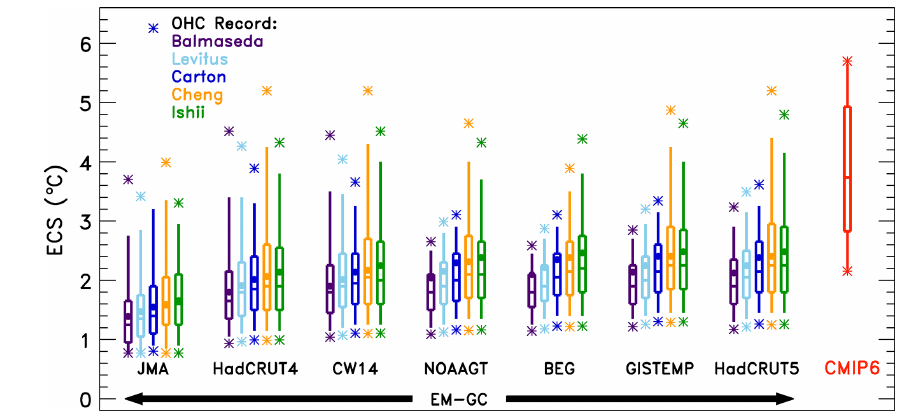
Figure 7. ECS from the EM-GC and the CMIP6 multi-model ensemble. Seven GMST data sets and five ocean heat content records are used to compare values of ECS computed from the EM-GC. The box represents the 25th, 50th, and 75th percentiles, the whiskers denote the 5th and 95th percentiles, and the stars indicate the minimum and maximum values of ECS using the EM-GC based on the weighting method described in Sect. 2.5. The circles denote the value of ECS associated with the best estimate of AER RF 2011 of − 0 . 9Wm − 2 . The red box labeled “CMIP6” represents the 25th, 50th, and 75th percentiles, the whiskers denote the 5th and 95th percentiles, and the stars indicate the minimum and maximum values of ECS from the 28-member CMIP6 multi-model ensemble.